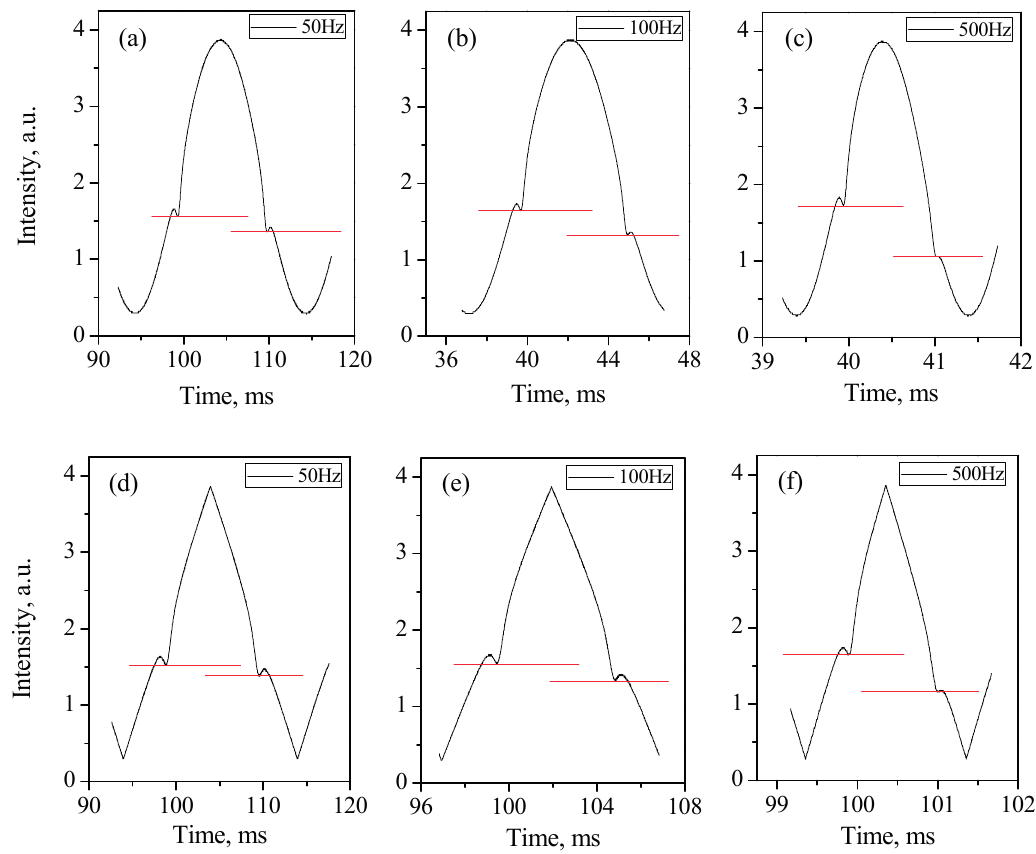
Figure 3. Transmitted intensity-time curves of sine and triangle modulation cases respectively at 50 Hz, 100 Hz and 500 Hz, specifically, ( a ) Sine wave modulation at 50 Hz; ( b ) Sine wave modulation at 100 Hz; ( c ) Sine wave modulation at 500 Hz; ( d ) Triangle wave modulation at 50 Hz; ( e ) Triangle wave modulation at 100 Hz; ( f ) Triangle wave modulation at 500